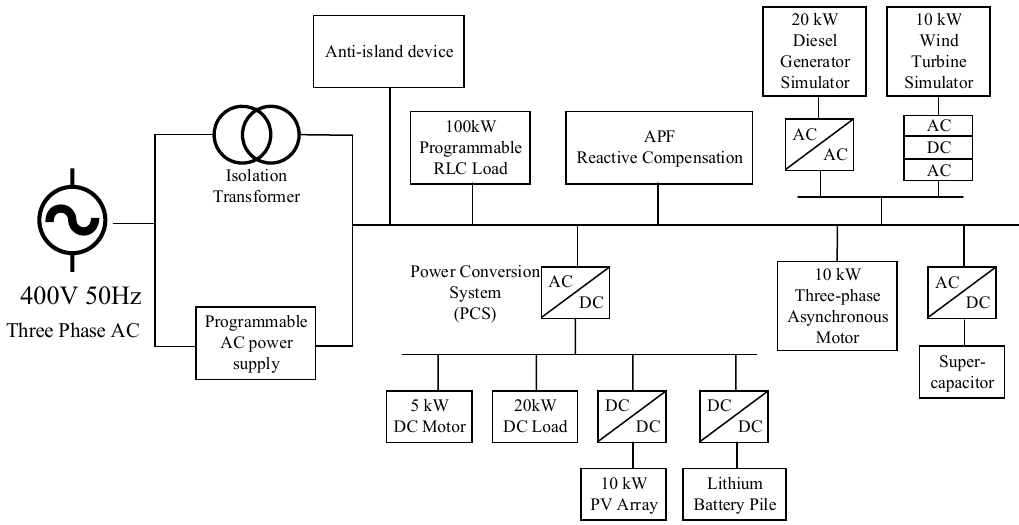
Figure 5. The architecture diagram of the experimental setup.